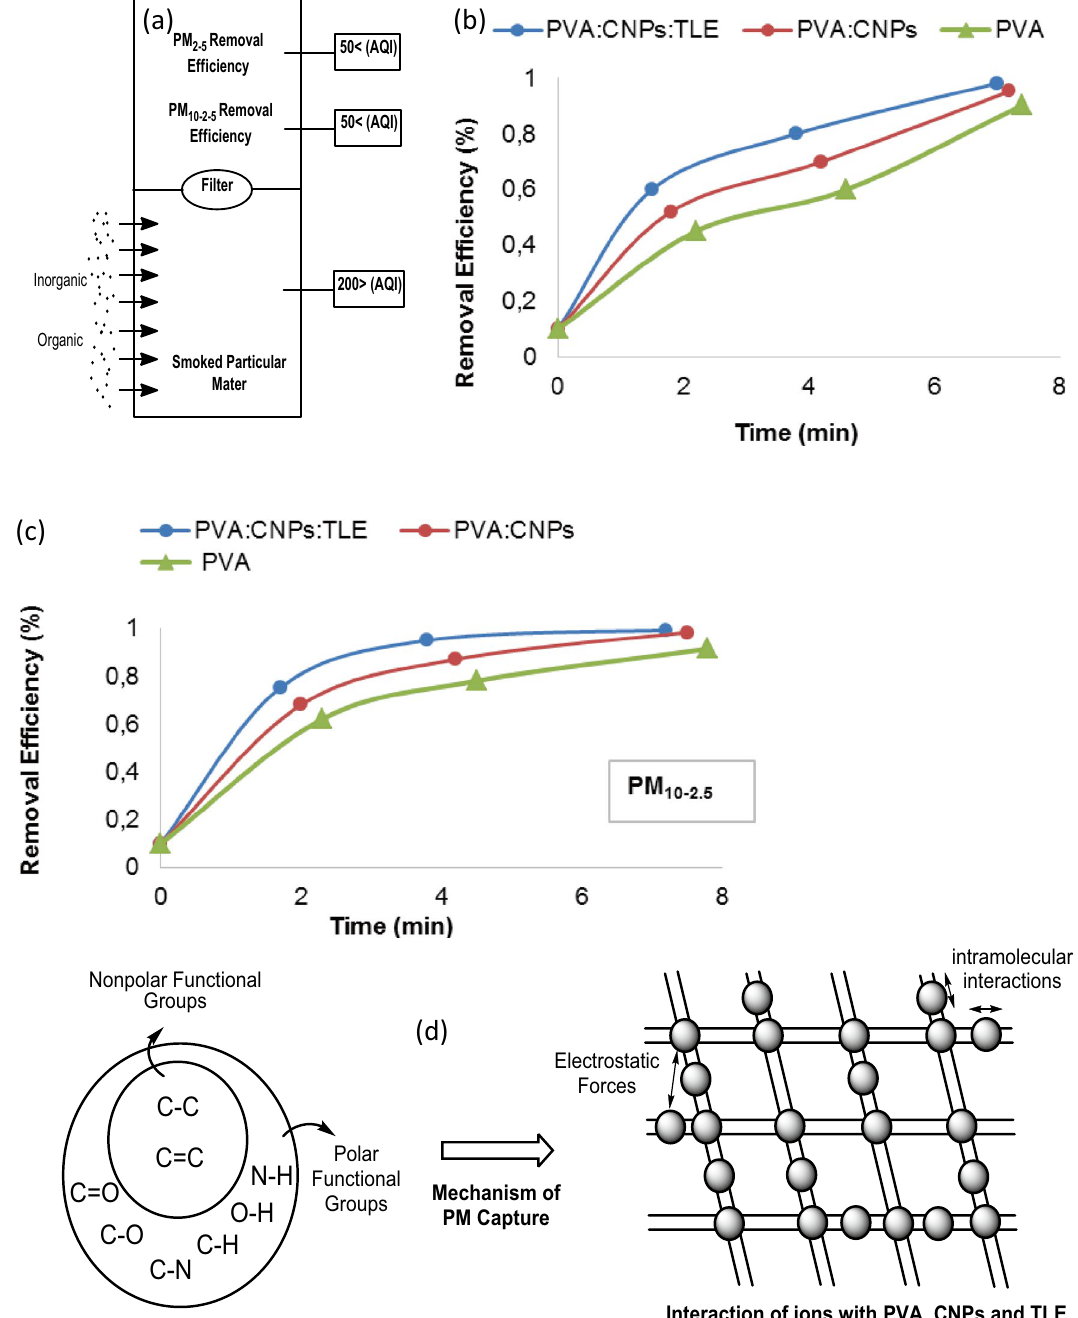
Figure 9. ( a ) The setup designed for testing the efficiency capture of PM 2.5 and PM 10–2.5 capture ( b ) PM 2.5 capture efficiency of PVA, PVA: CNPs and PVA: CNPs: TLE ( c ) PM 10–2.5 capture efficiency of PVA, PVA: CNPs and PVA: CNPs: TLE ( d ) Schematic showing the mechanism of PM